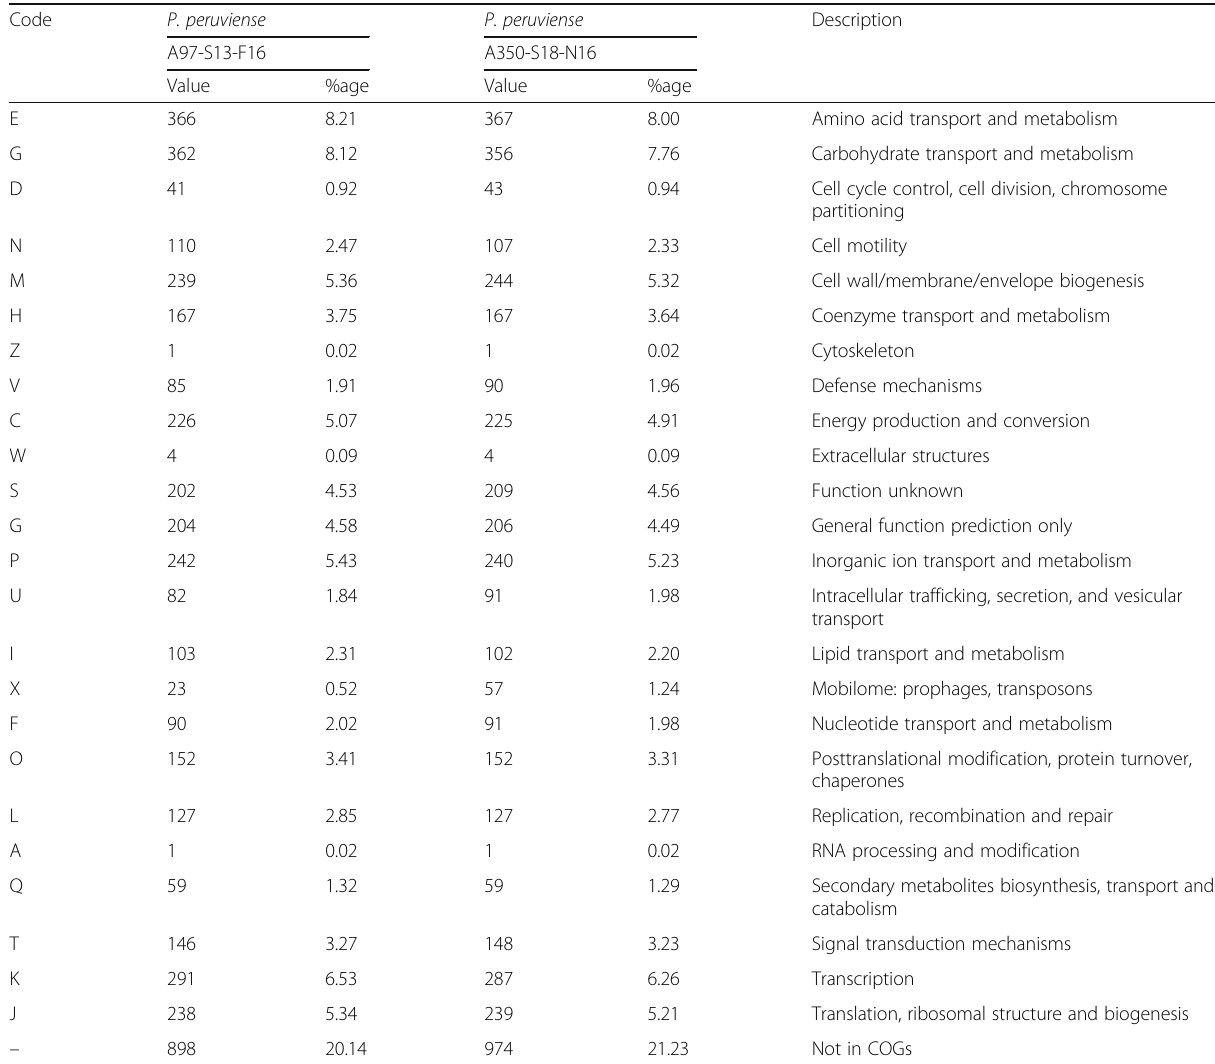
Table 4 Number of genes associated with the 25 COG functional categories